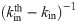
Relaxation of the CCC model after changes in kin.(A) Time evolution of carriers and the metabolite following the change in kin. Initially, kin was set to 1.1, and the system reached the steady state. Subsequently, kin was changed from 1.1 to 0.9 at time = 0.0. (B) Changes in the relaxation time with kin. The initial conditions were set as [m0] = 100.0, [m1] = [m2] = 0.0, [c] = cpool, and [c*] = 0. kleak was set to 0. The green dashed line represents (kinth-kin)-1, where kinth is 0.984313. Inset: Semi-log plot of τ vs. kin.